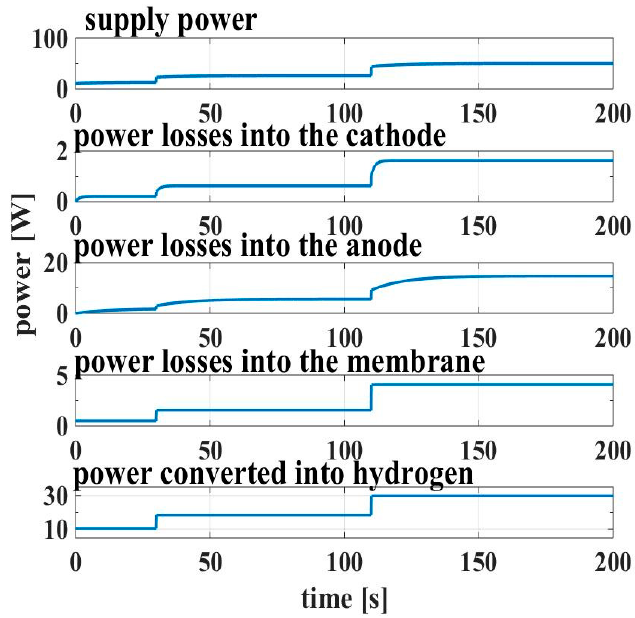
Figure 16. Power balance of the PEM EL.